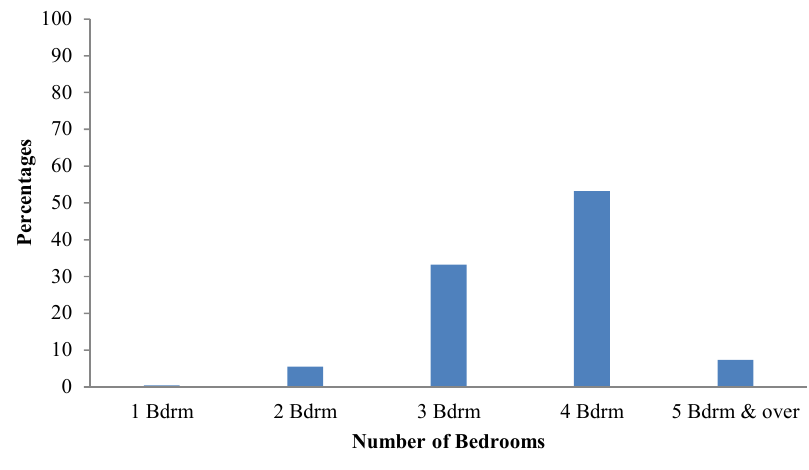
Figure 2. Distribution of defects per number of